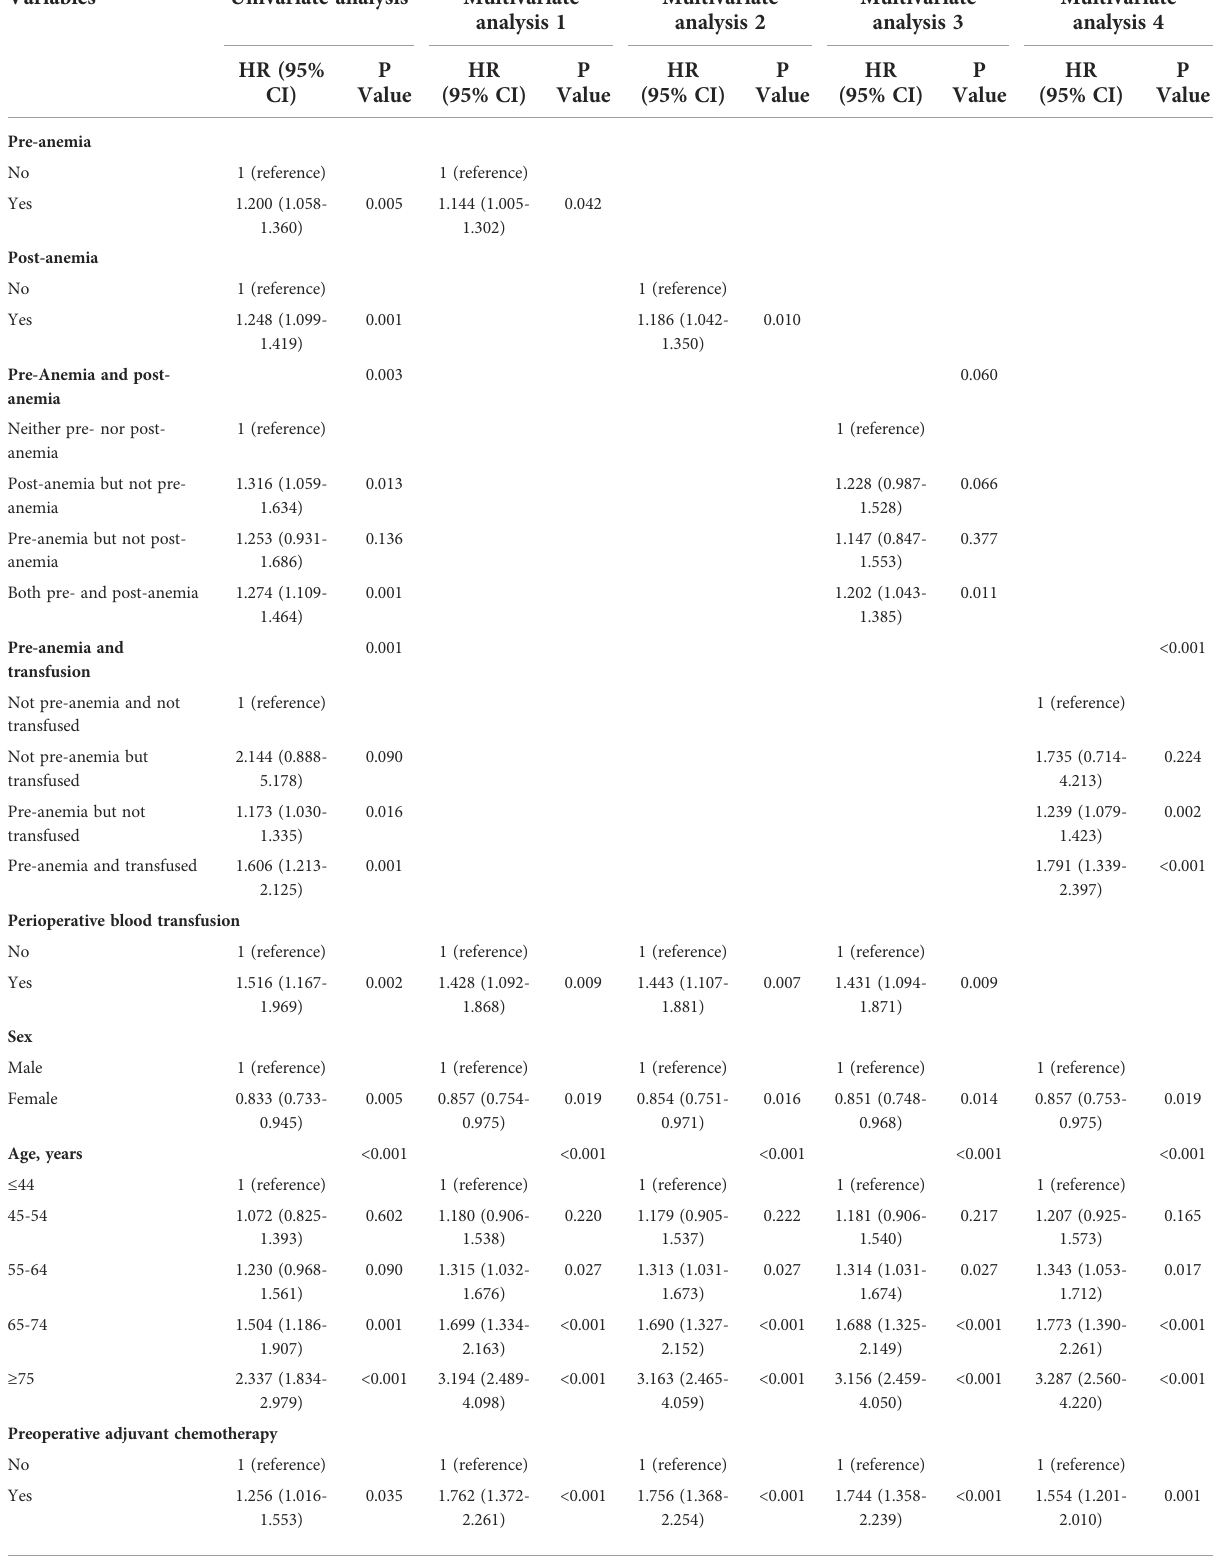
TABLE 3 Univariate analysis and multivariate Cox regression analysis for overall survival in the Propensity score matched